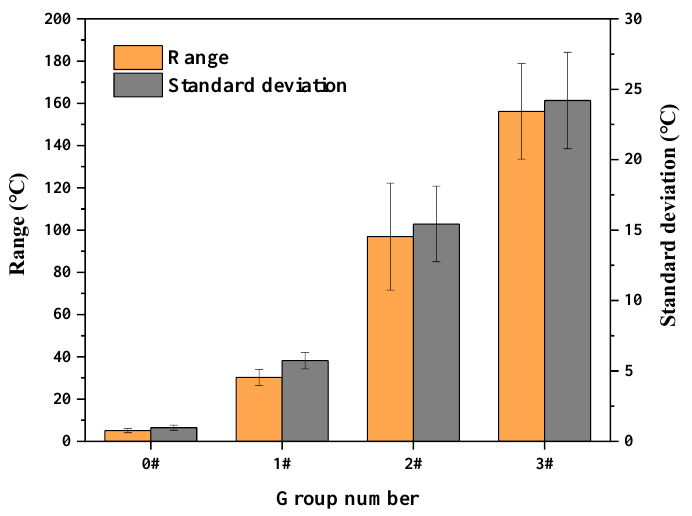
Figure 8. Temperature range and standard deviation of UMLs with different SiC particle sizes.